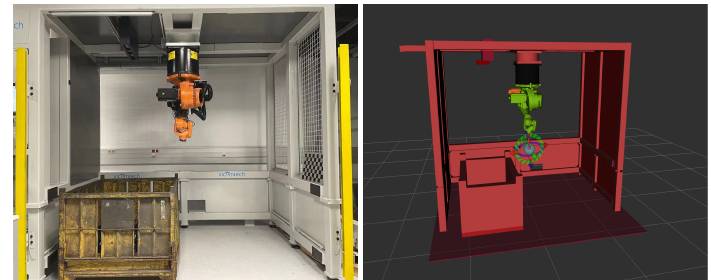
Figure 8. The environment setup for Use Case 2, ( left ): the real scene, ( right ): the virtual scene in moveit.